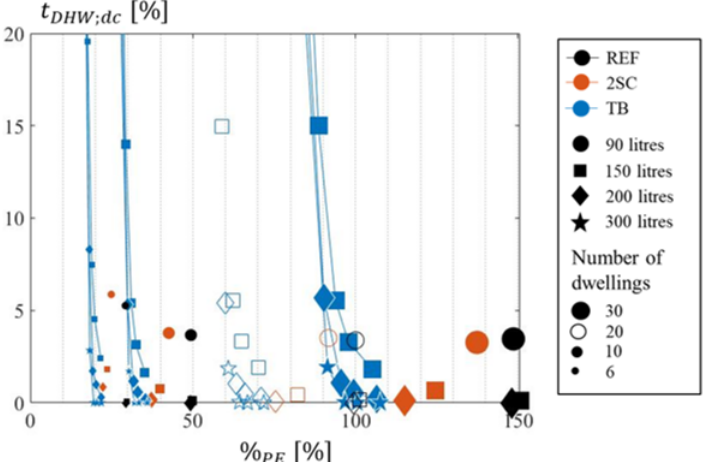
Figure 9. Pareto plot of t DHW ; dc and % PE for a decreasing number of dwellings. The blue data points are for TB-control, red for 2SC, and black for reference control. The size of the data point reflects the number of dwellings (those without a face colour are for 20 dwellings, i.e., the reference